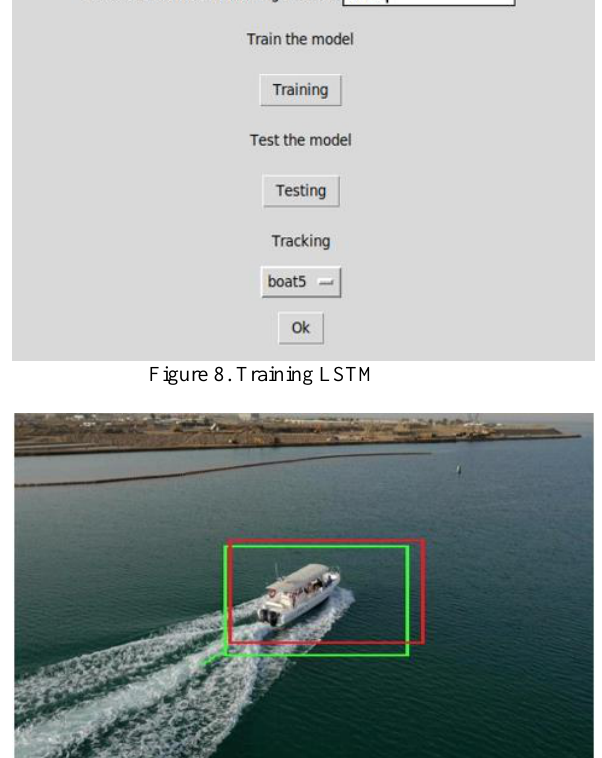
Figure 9. Tracked object with trajectory. The red box indicates the groundtruth and green box indicates the tracked object